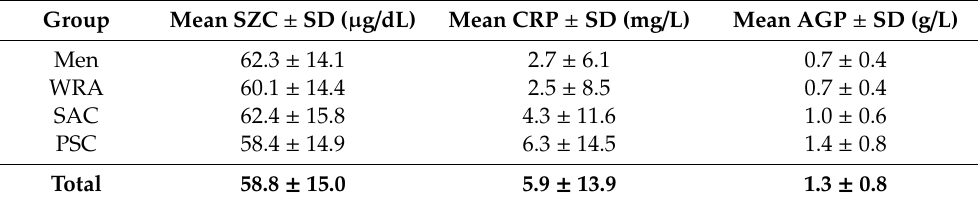
Table 2. Summary of concentrations of SZC, CRP and AGP of the participants in the Malawi